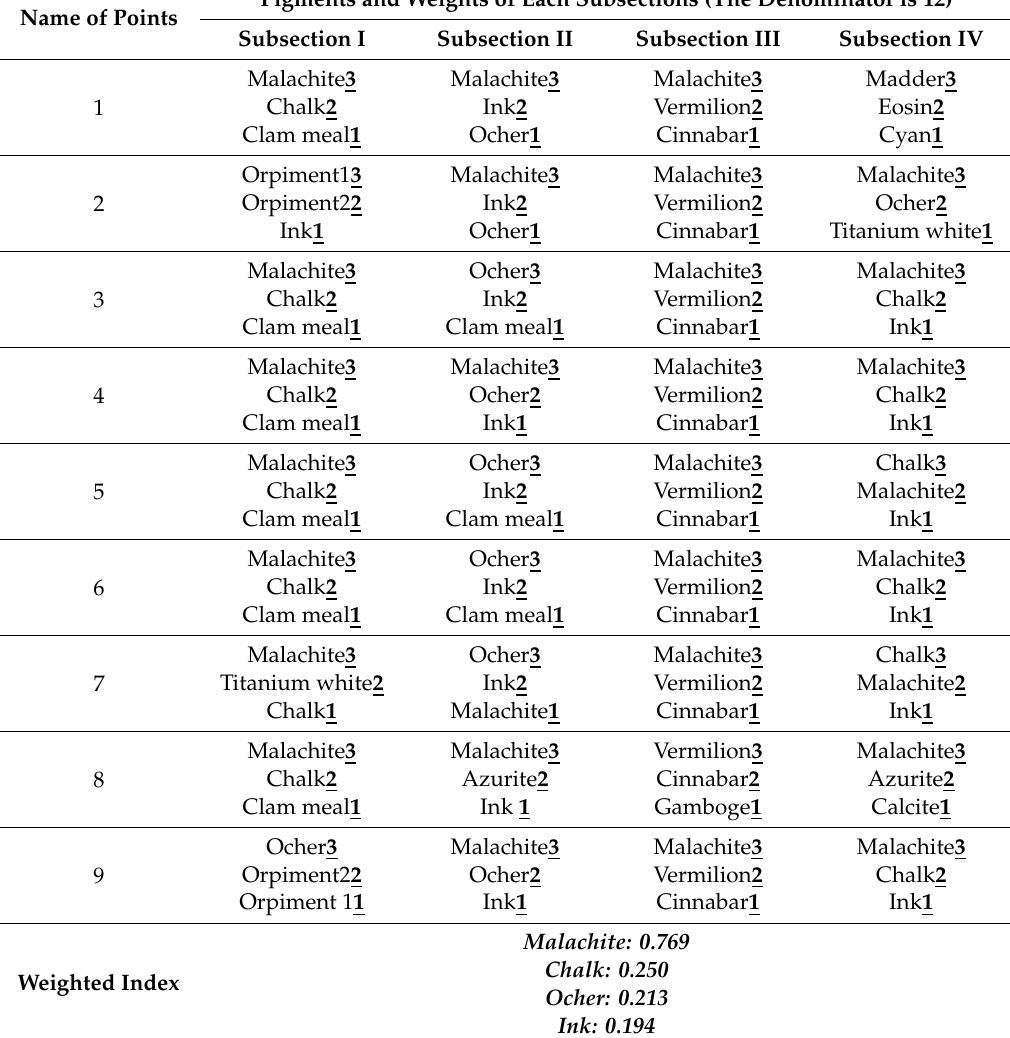
Table 10. The identification results and weights of each subsection in region